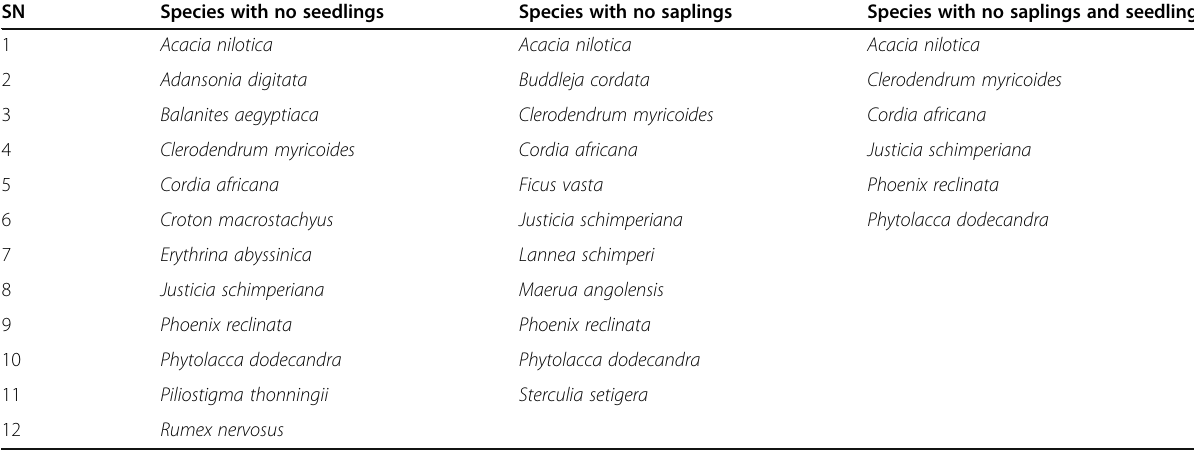
Table 6 Regeneration status classification of woody species for conservation priority SN Species with no seedlings Species with no saplings Species with no saplings and